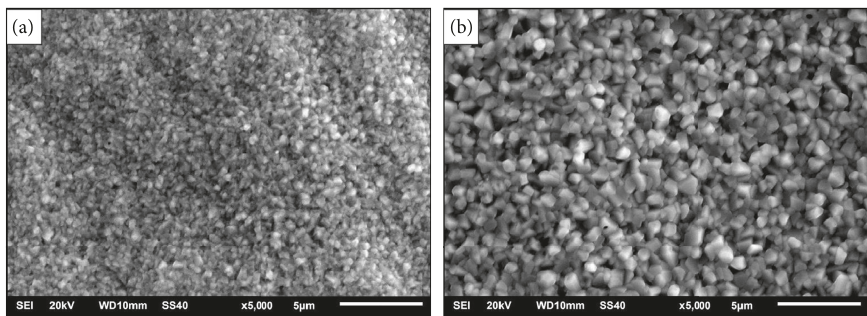
3 O 4 composite coating by electro-codeposition.